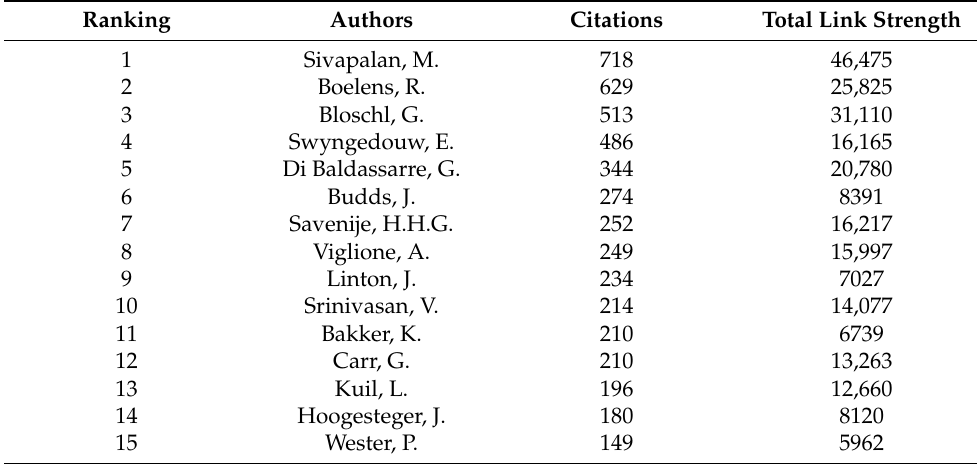
Table 4. Top 15 most co-cited